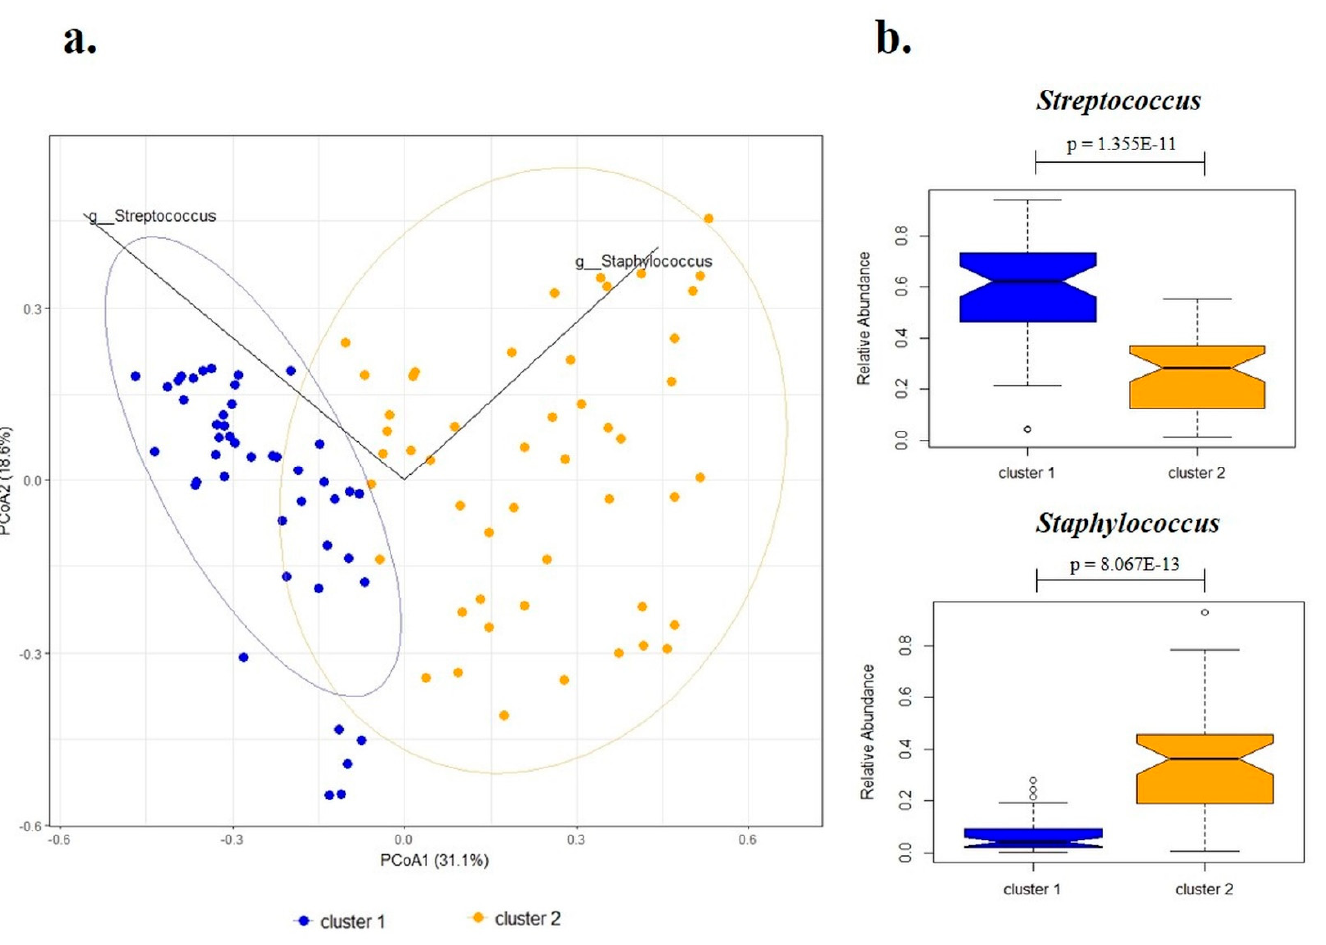
Figure 2. Clusters identified in human milk samples. ( a ) Principal Coordinate Analysis (PCoA) clustering of human milk samples driven by Streptococcus (cluster 1) and Staphylococcus (cluster 2). ( b ) Relative abundance of bacterial taxa characteristic in each cluster. Box-plot representing the interquartile range (IQR) and the line inside represents the median. Small circles denote outliers. Legend: Mann-Whitney test was performed to compare the relative abundance between the clusters.